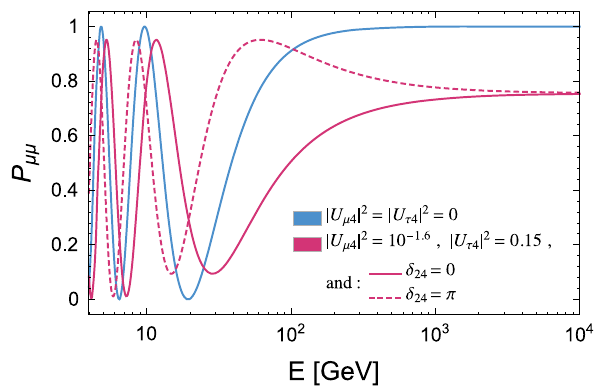
Fig. 1 Muon neutrino survival probability using Eq. (11) as a func- tion of energy. The blue curve shows the oscillation probability without sterile mixing, while the magenta solid (dashed) curve shows the prob- ability for | U μ 4 | 2 = 10 − 1 . 6 , | U τ 4 | 2 = 0 . 15, and δ 24 = 0 ( δ 24 = π